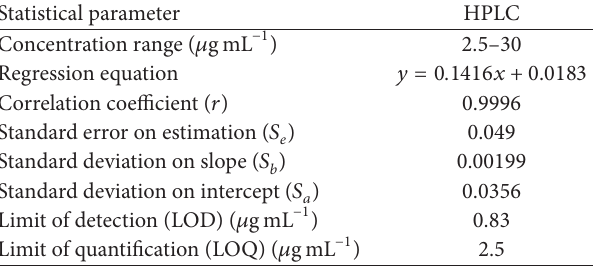
T 5: Data from the analysis of commercial tablets by HPLC